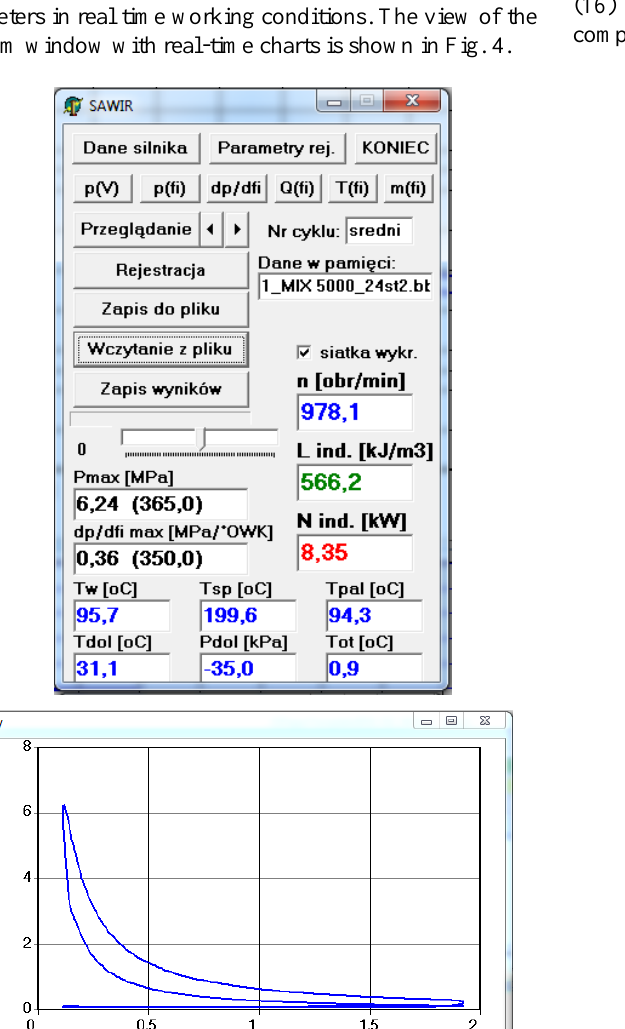
The exhaust gas analyzer Radiotechnika model AI9600 (16) is used to measure the concentration of toxic exhaust